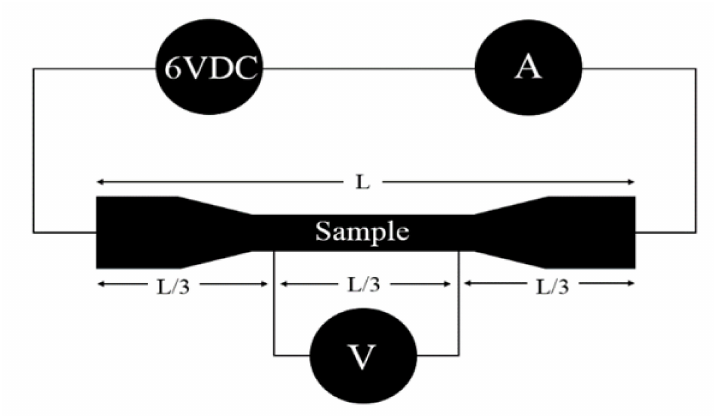
Figure 3. Schematic image of the four-point probe setup for the electrical conductivity